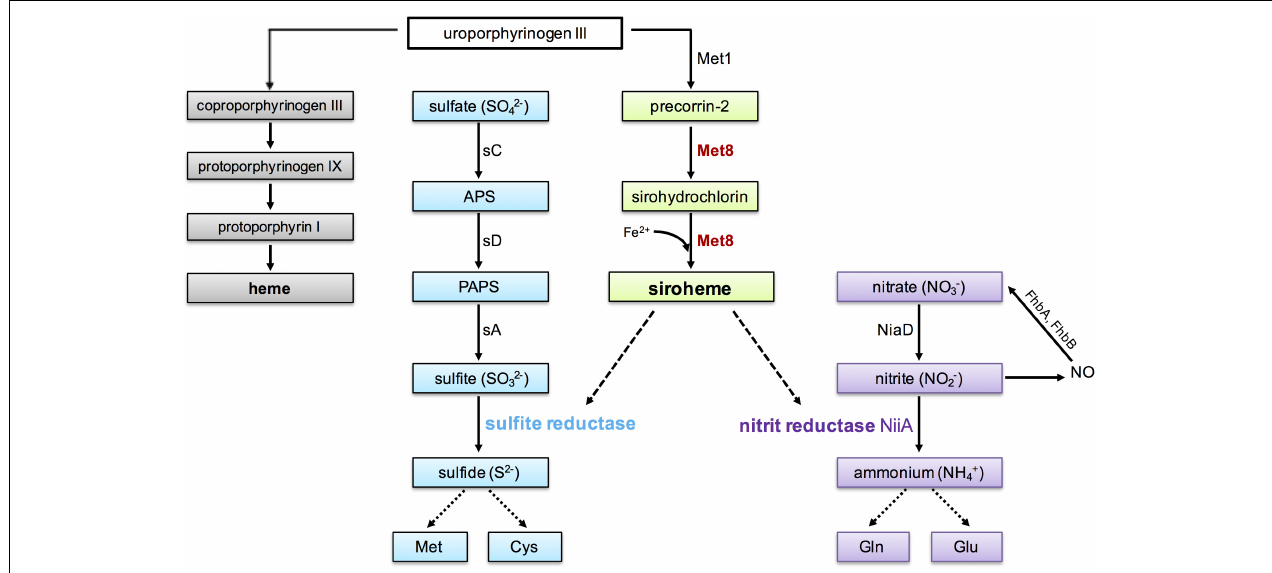
FIGURE 1 | Biosynthesis of siroheme and heme from uroporphyrinogen III and assimilation of sulfur and nitrogen in Aspergillus fumigatus . Heme biosynthesis is shown in gray, siroheme biosynthesis in green, assimilation of sulfate in blue and nitrate, as well as NO detoxification is shown in purple. The bifunctional protein Met8 (precorrin-2 dehydrogenase/siroheme ferrochelatase, AFUA_7G05680), investigated in the current study is highlighted in red. Dashed lines demonstrate the requirement of siroheme as cofactor for the β -subunit of sulfite reductase (AFUA_2G15590/homolog of Saccharomyces cerevisiae Met5) and nitrite reductase (AFUA_1G12840/NiiA), respectively. Notably, sulfite reductase has a second subunit (AFUA_6G08920/sF). Nitric oxide (NO) radicals are detoxified via nitrite by the cytosolic flavohemoglobin FhpA (AFUA_4G03410) and the mitochondrial flavohemoglobin FhpB (AFUA_8G06080). APS: adenosine 5 (cid:48) -phosphosulfate; PAPS: 3 (cid:48) -phosphoadenosine-5 (cid:48) -phosphosulfate; Met1: uroporphyrin-III C-methyltransferase (AFUA_3G06600); sC: ATP-sulfurylase (AFUA_3G06530); sD: APS kinase (AFUA_1G10820); sA: PAPS reductase